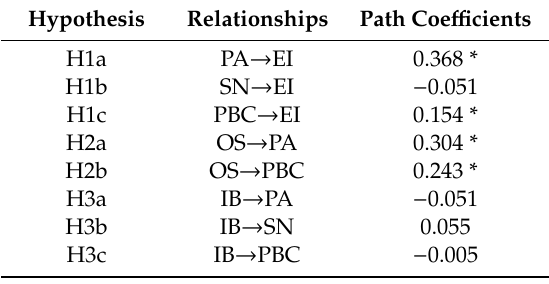
Table 7. Direct, indirect, and total e ff ects on entrepreneurial intent.